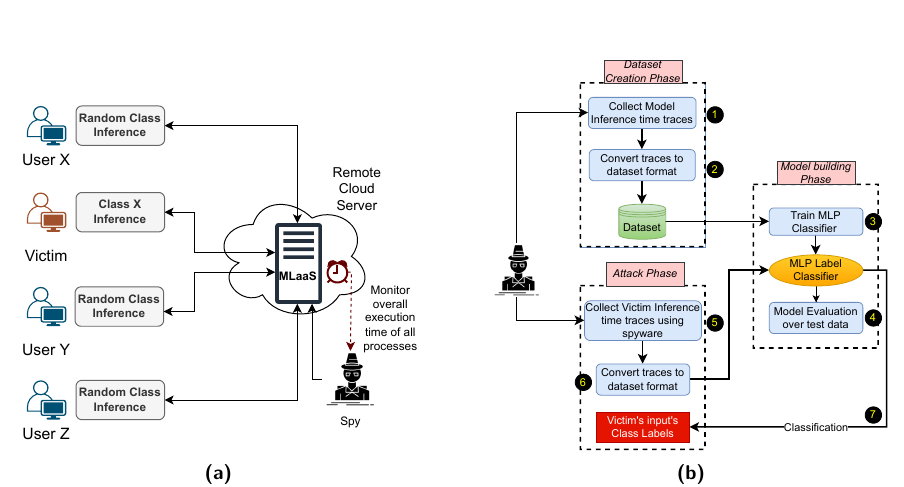
Figure 7: (a) Threat Model for Privacy Leakage in a Client-Server MLaaS Framework (b) Attack Methodology: The process goes through three stages (i) Dataset creation Phase, (ii) Model Building Phase and (iii) Attack Phase (The numbered circles indicate the order of the